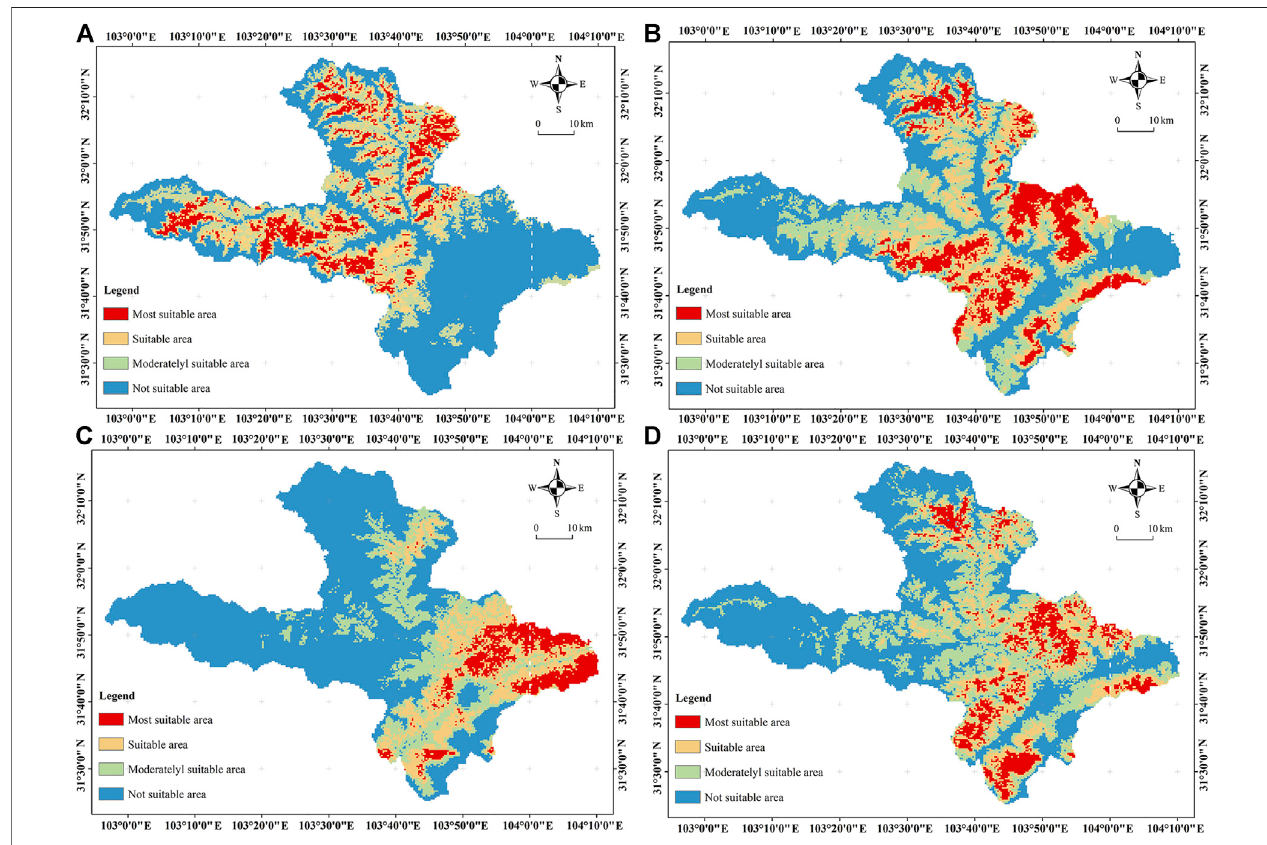
FIGURE 4 | Distribution patterns of suitable areas of four tree species: (A) Abies ; (B) Picea ; (C) Quercus ; and (D) Betula .